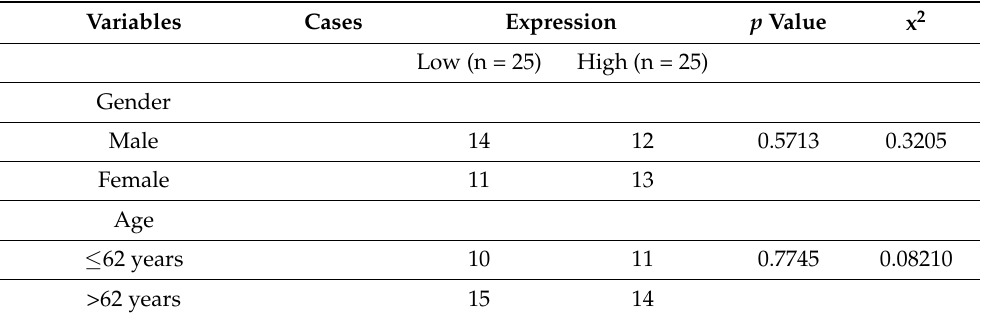
Figure 2. circ_RNF13 and DDX27 are upregulated in CRC tumor samples and cells. ( A ) The level of circ_RNF13 in CRC tumor samples was detected by qRT-PCR. ( B ) The correlation of circ_RNF13 level with OS of CRC patients. ( C ) Analysis of DDX27 expression in CRC tumor samples based on TCGA database. ( D ) The protein level of DDX27 in CRC tumor samples was detected by Western blot analysis. ( E ) The level of circ_RNF13 in CRC cells (CoLo205, DLD-1, HT-29, CoLo320, RKO, NCI-H716, and Caco-2) and normal colon cell line NCM-460 cells was detected by qRT-PCR. ( F ) The protein level of DDX27 in CRC cells (CoLo205, DLD-1, HT-29, CoLo320, RKO, NCI-H716, and Caco-2) and NCM460 was detected by Western blot analysis. Each experiment was performed at least three times independently. *, p < 0.05, **, p < 0.01, ***, p < 0.001. Full pictures of the Western blots are presented in Figure S2. Table 3. Relationships between circ_RNF13 expression and the clinicopathological characteristics of CRC